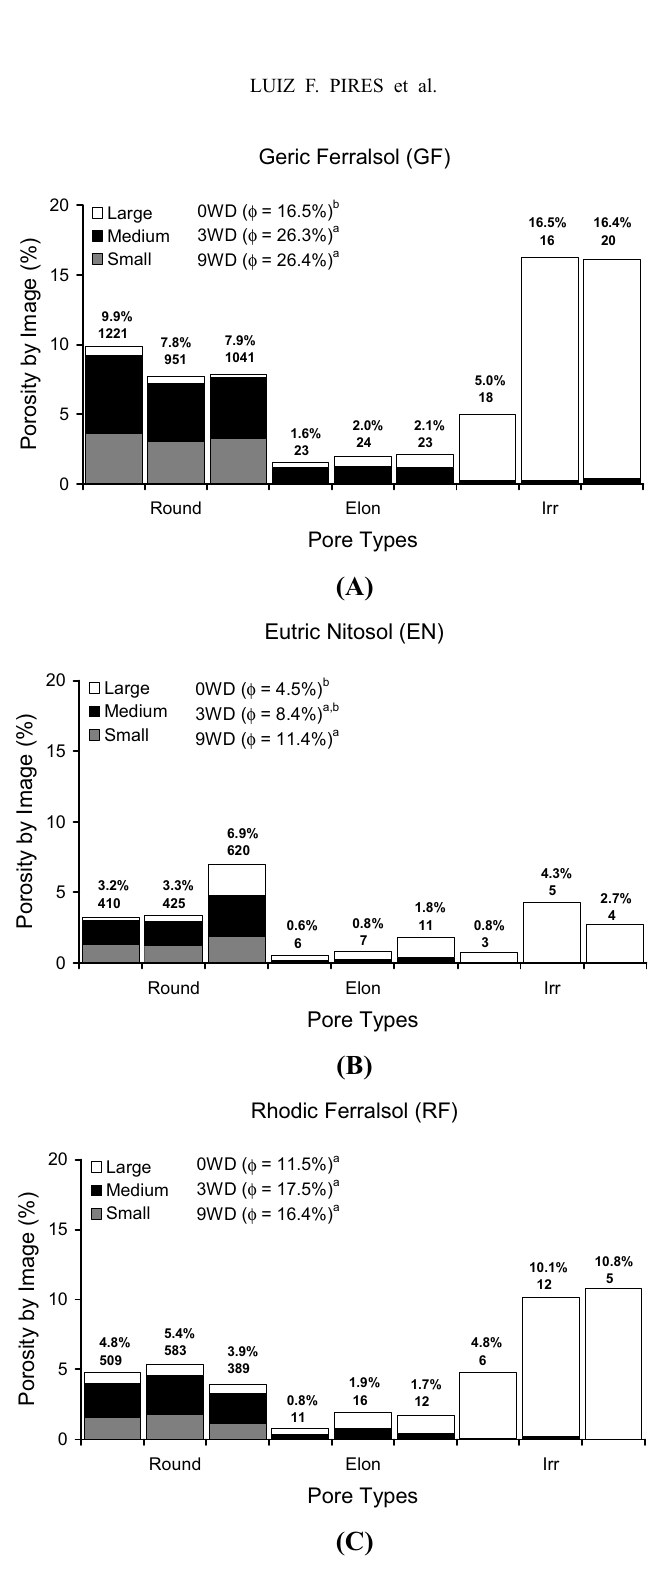
Fig. 2 – Effects of wetting and drying (W-D) cycles on the pore shape of damaged samples for the three soils. Round = rounded; Elon = elongated; Irr = irregular; φ = total porosity by image; TNP = total number of pores; 0WD (samples not submitted to W-D cycles), 3WD (samples submitted to 3 W-D cycles), and 9WD (samples submitted to 9 W-D cycles) treatments; Porosity values followed by the same letters are not significantly different according to the Duncan test (α = 0 . 05 )